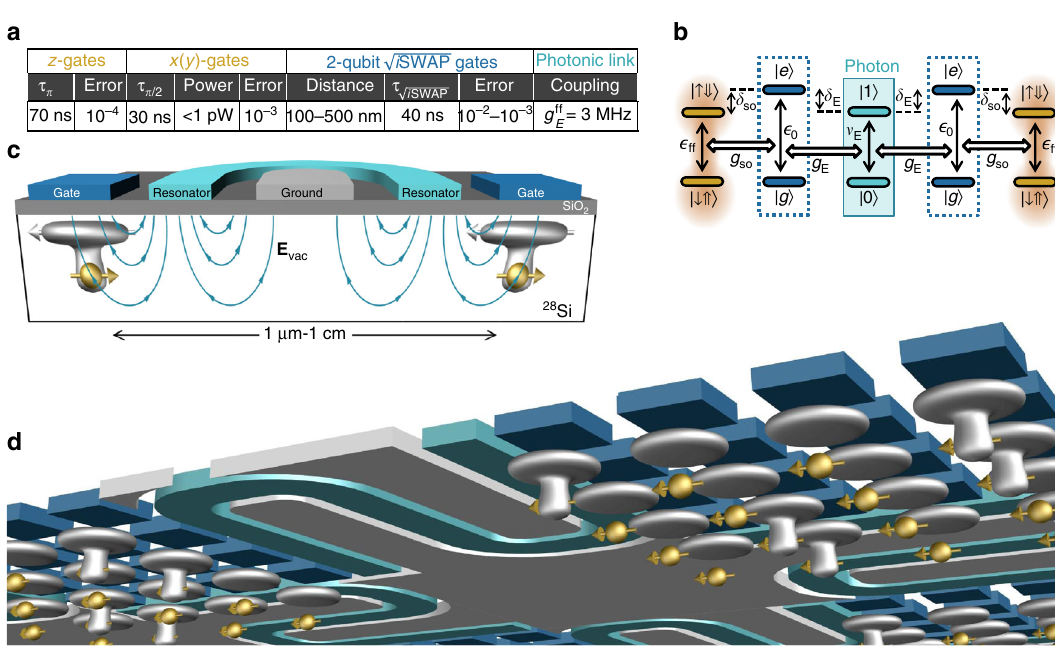
Fig. 7 Silicon hybrid quantum processor. a Figures of merit summarizing the speed and error rates of different gate schemes presented in this paper, assuming realistic noise sources. b Level diagram for distant fl ip- fl op qubit coupling via a microwave resonator showing photon number states and off- resonant charge states. c Device scheme for coupling qubits via a photonic link. Distant donors, placed next to the resonator center line and biased to their ionization point, are subject to the vacuum electric fi eld E vac of a shared microwave resonator. d Schematic view of a large-scale quantum processor based upon 31 P donors in Si, operated and coupled through the use of an induced electric dipole. Idle qubits have electrons at the interface, leaving the 31 P nucleus in the ultra-coherent ionized state. Electrons are partially shifted toward the donor for quantum operations. The sketch shows a possible architecture where a cluster of qubits is locally coupled via the electric dipole, and a subgroup thereof is further coupled to another cluster through interaction with a shared microwave cavity ( aqua ). The drawing is not to scale; control lines and readout devices are not − 3 − − 2 10 10 for a wide range of V t . Finally, we estimate in Fig. 6c how noise errors depend on the noise amplitude and adiabatic factor K , which sets the gate time.